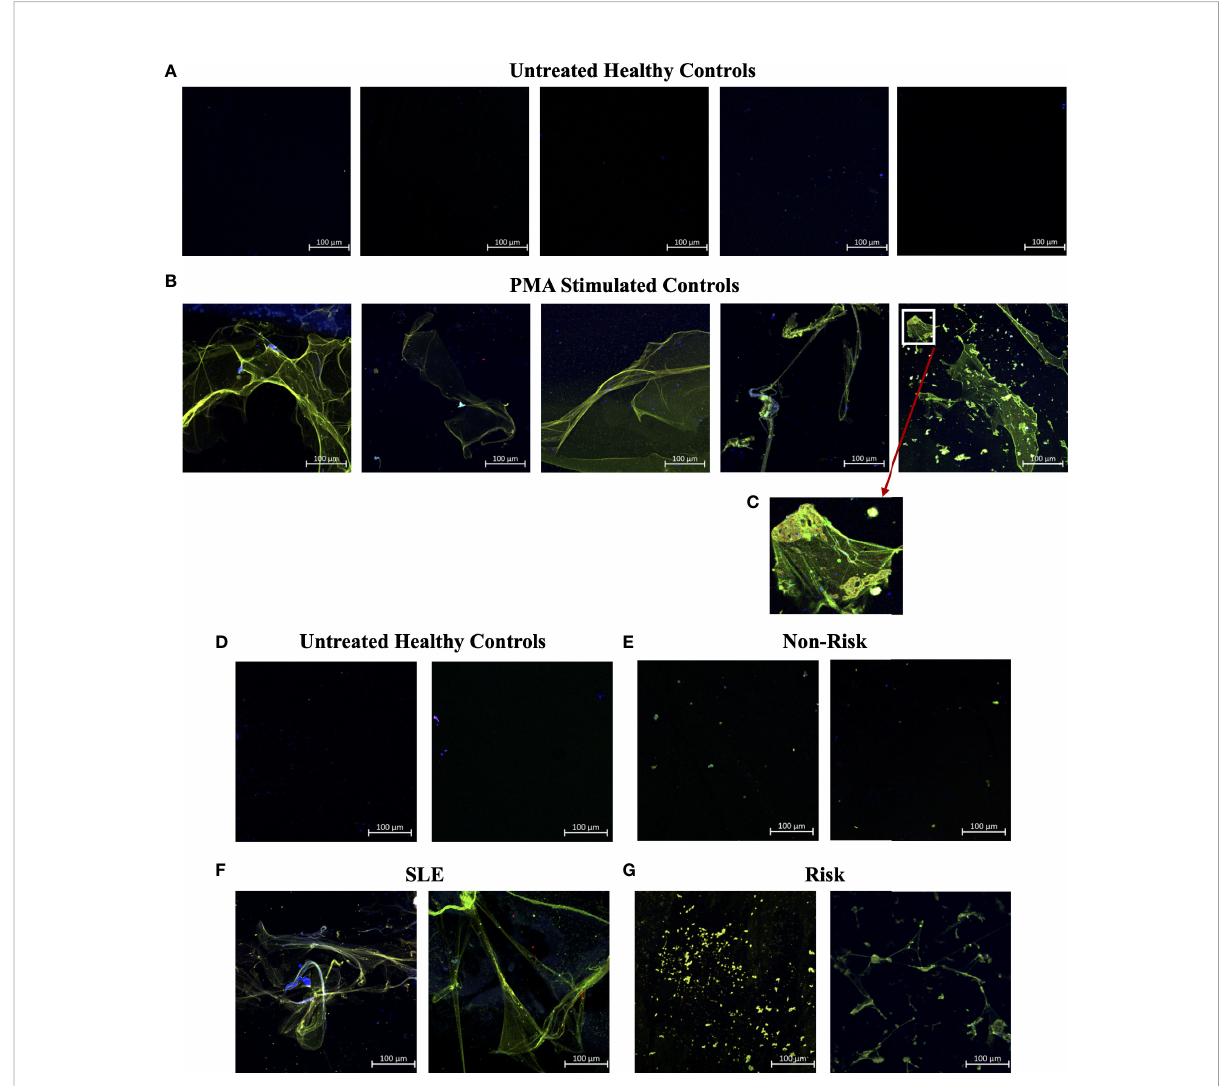
FIGURE 4 Smear assay showing higher NETs in plasma from PMA stimulated samples, SLE samples, and risk GaP patient samples when compared to healthy donors. Representative images of plasma smeared poly-l-lysine slides stained with MPO (green, AF488), CitH3 (red, AF594) and DAPI (Blue). (A) Untreated healthy plasma smears display lower concentration of circulating NETs than (B) plasma of PMA stimulated samples. (C) Last image of PMA stimulated sample zoomed in 5x to show differential staining of MPO (green) and CitH3 (red) antibodies. (D) Healthy donor and (E) non-risk donor samples also show lower concentration of circulating NETs than (F) plasma of SLE and (G) IRF5 homozygous risk donors. Individual merged images represent separate donors (n=18). All images were taken on ZEISS Confocal M880 at 20x objective. Set scale